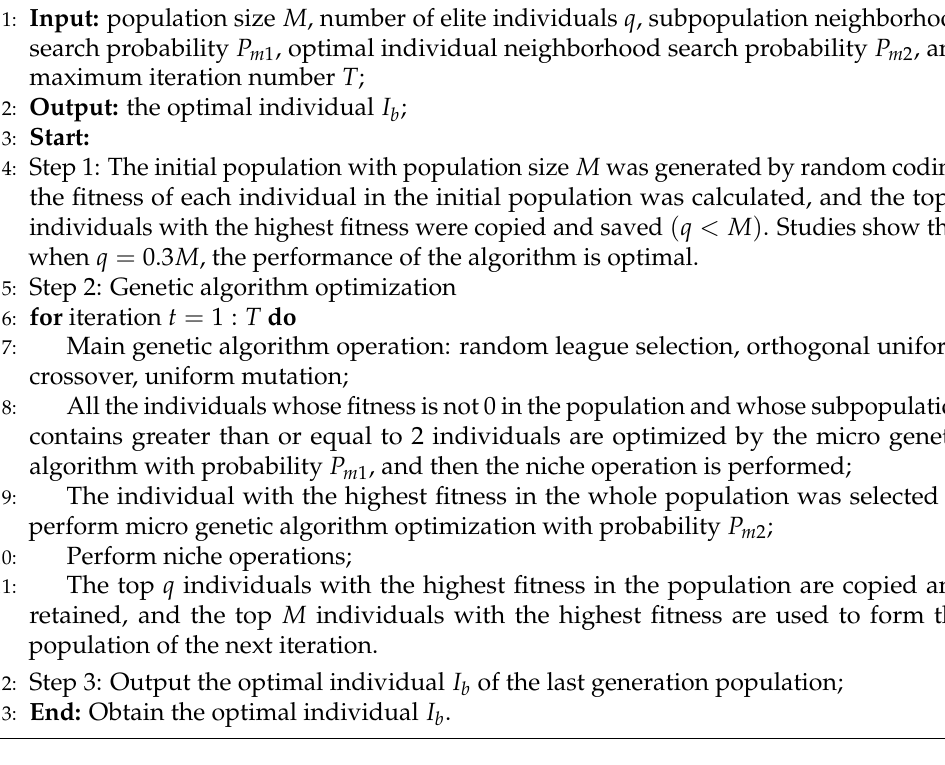
Algorithm 1 HNOGA